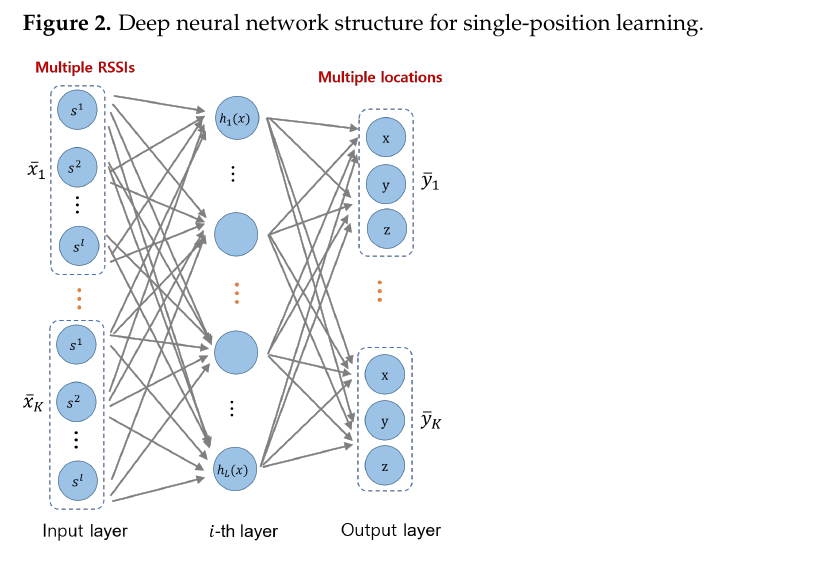
Figure 3. Extended deep neural network structure for multi-position